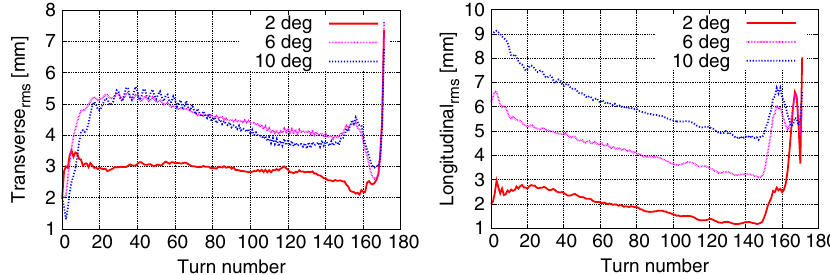
FIG. 8. (Color) Comparison of the rms beam size in the transverse direction (left) and longitudinal direction (right) at the 112 (cid:6) azimuthal position of each turn in the PSI ring